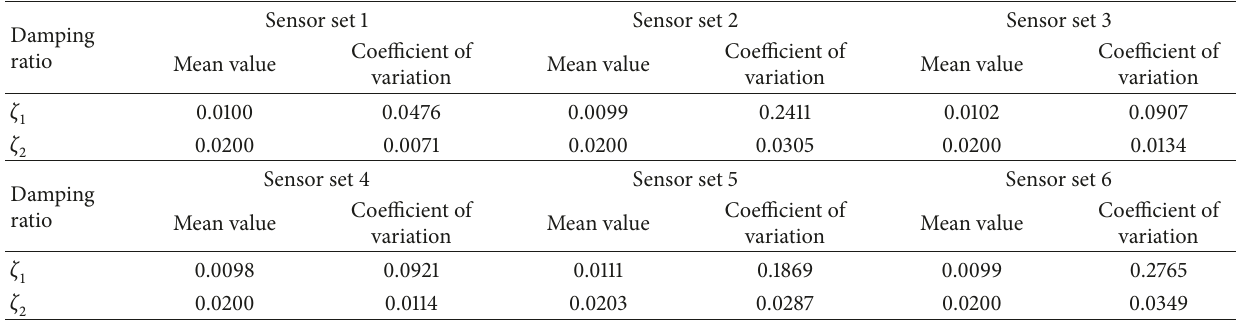
Table 6: Identification results with proposed method.